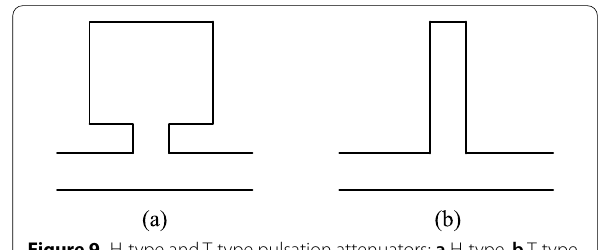
Figure 9 H-type and T-type pulsation attenuators: a H-type, b